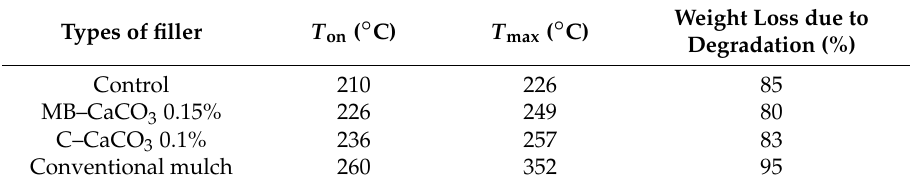
Figure 2. Thermogravimetric analysis (TGA) curves of control, C–CaCO 3 based seaweed, MB–CaCO 3 based seaweed, and conventional films. Table 4. Thermal analysis of seaweed-based films and conventional mulch film.